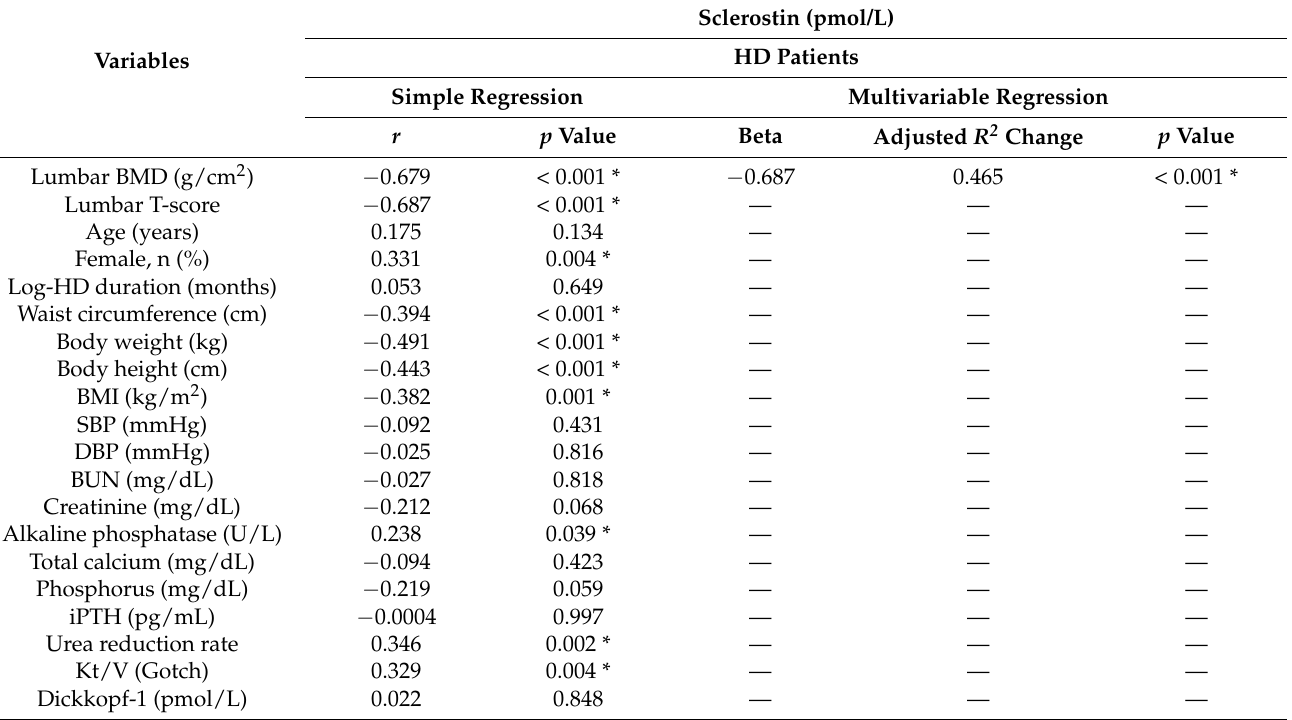
Table 4. Correlation of sclerostin levels and clinical variables by simple or multivariable linear analyses of the hemodialysis